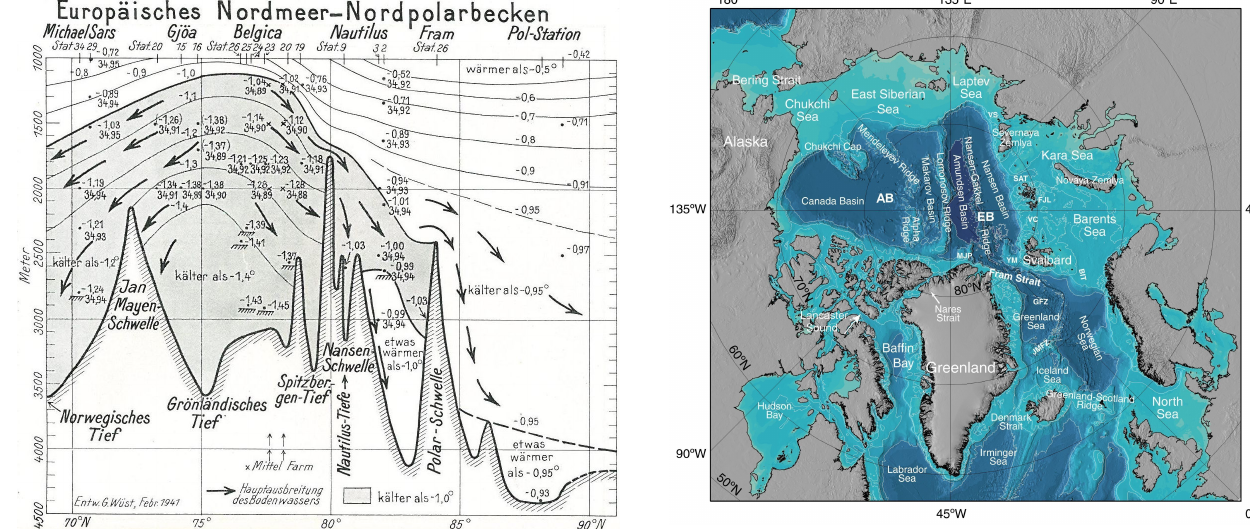
Fig. 3. A temperature section from the Nordic Seas into the Arc- tic Ocean compiled by W¨ust from available observations taken be- tween the 1880s and the 1930s. From W¨ust (1941).